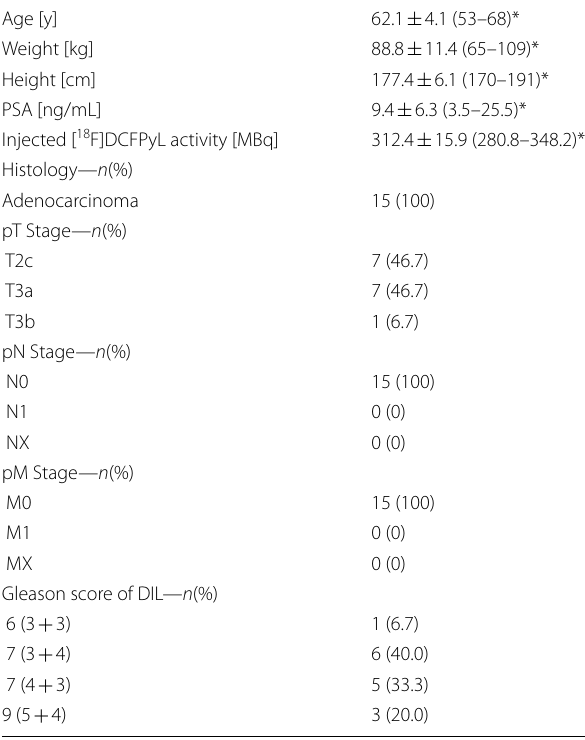
Table 1 Clinical–pathological characteristics of patients